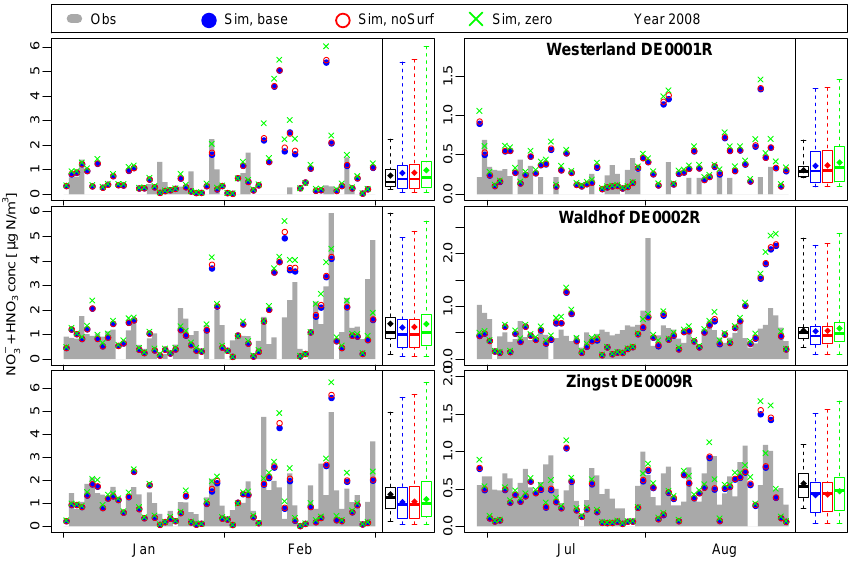
Figure 7. Similar to Fig. 6 but showing sNO 3